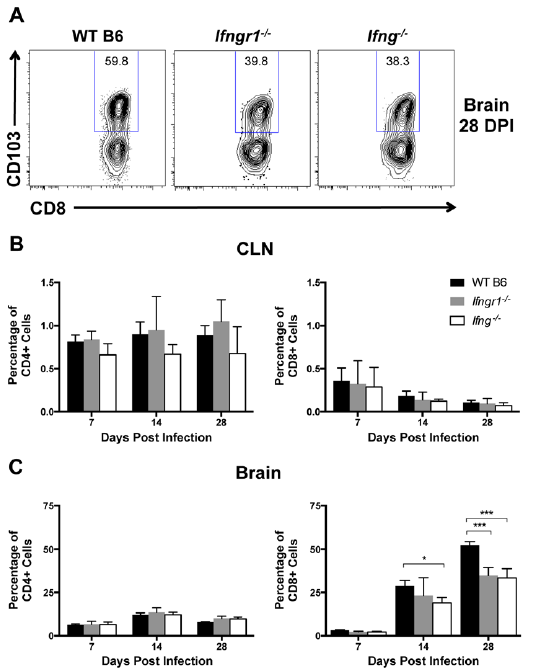
Figure 11. Effect of IFN- γ signaling on T RM cell populations. Flow cytometry was used to examine T RM cell populations by gating, denoted by blue frames, around CD103 + cells ( A ) at 7, 14, and 28 DPI in the CLNs ( B ) and brains ( C ) of WT (black bars), Ifngr1 −/− (gray bars), and Ifng −/− (white bars) mice, and results are presented as a percentage of CD4 + ( left graphs ) and CD8 + T cells ( right graphs ) ( n = 2–7 pooled mice per strain per time point from three to four independent experiments; data are presented as the mean ± SEM; * p < 0.05, *** p < 0.001 by Tukey’s multiple comparisons test).